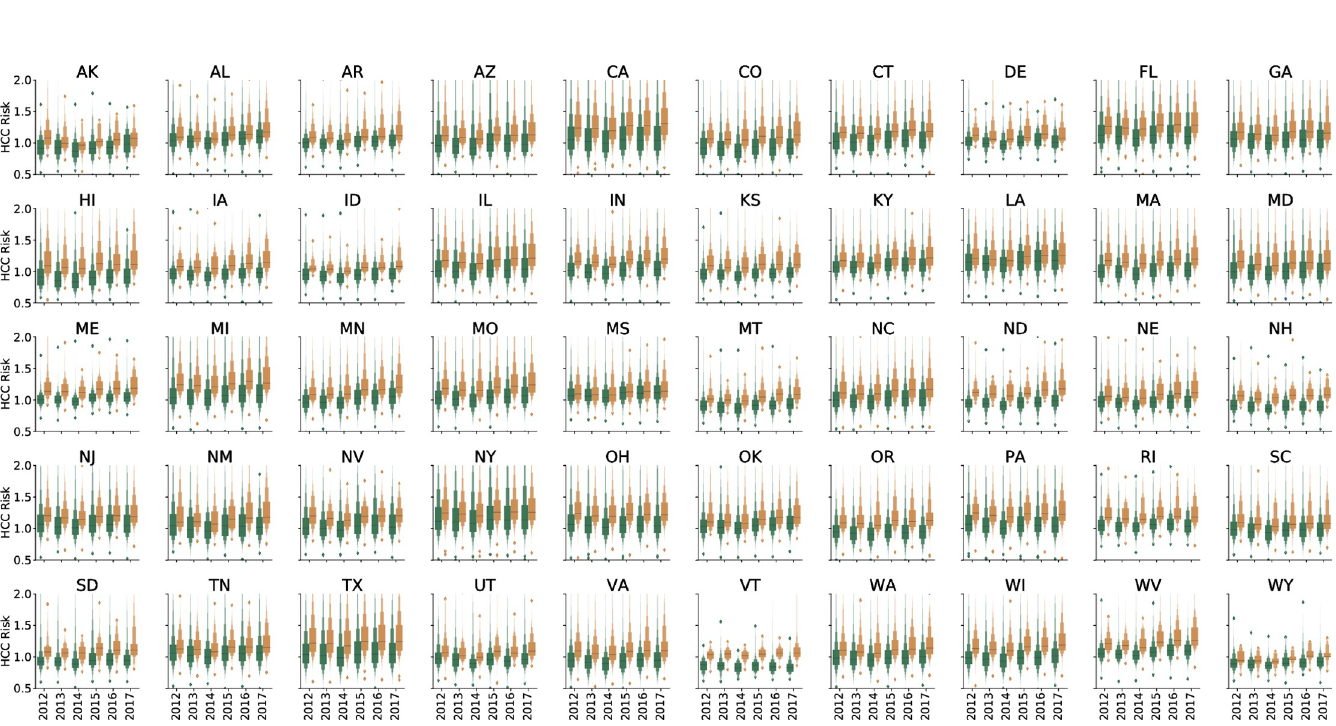
Fig 4. Letter value plot for average Hierarchical Condition Category (HCC) risk score by state and eye provider type. Ophthalmologists are shown in yellow and optometrists are shown in green. The black line represents the median value.